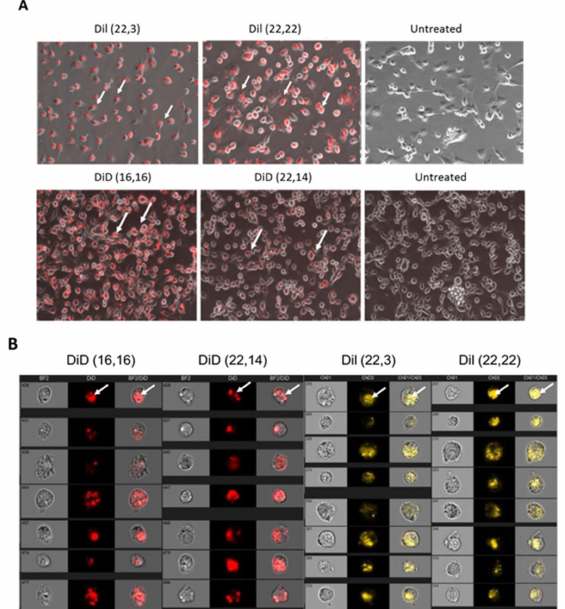
Figure 4. SapC-DOPS nanovesicles assembled with the iodinated phenolic DiI or DiD compounds robustly target GBM cells and are internalized. ( A ) U87 ∆ EGFR cells were incubated with 6 µ g of the compounds for 3 h then examined with fluorescent microscopy. Note the red fluorescence (arrows) of iodinated phenolic compound SapC-DOPS in the left and middle panels compared to the untreated cells in the right panels. ( B ) U87 ∆ EGFR cells treated for 3 h with 6 µ g of the indicated compounds were washed and analyzed by ImageStream flow cytometry for single cell visualization. Arrows show the internalized DiI / DiD fluorescence signal. The first column for each compound shows the bright field image of the cells; the second column is the fluorescence (red for DiD and yellow for DiI) of the compound and the third is the overlay showing that the compound is